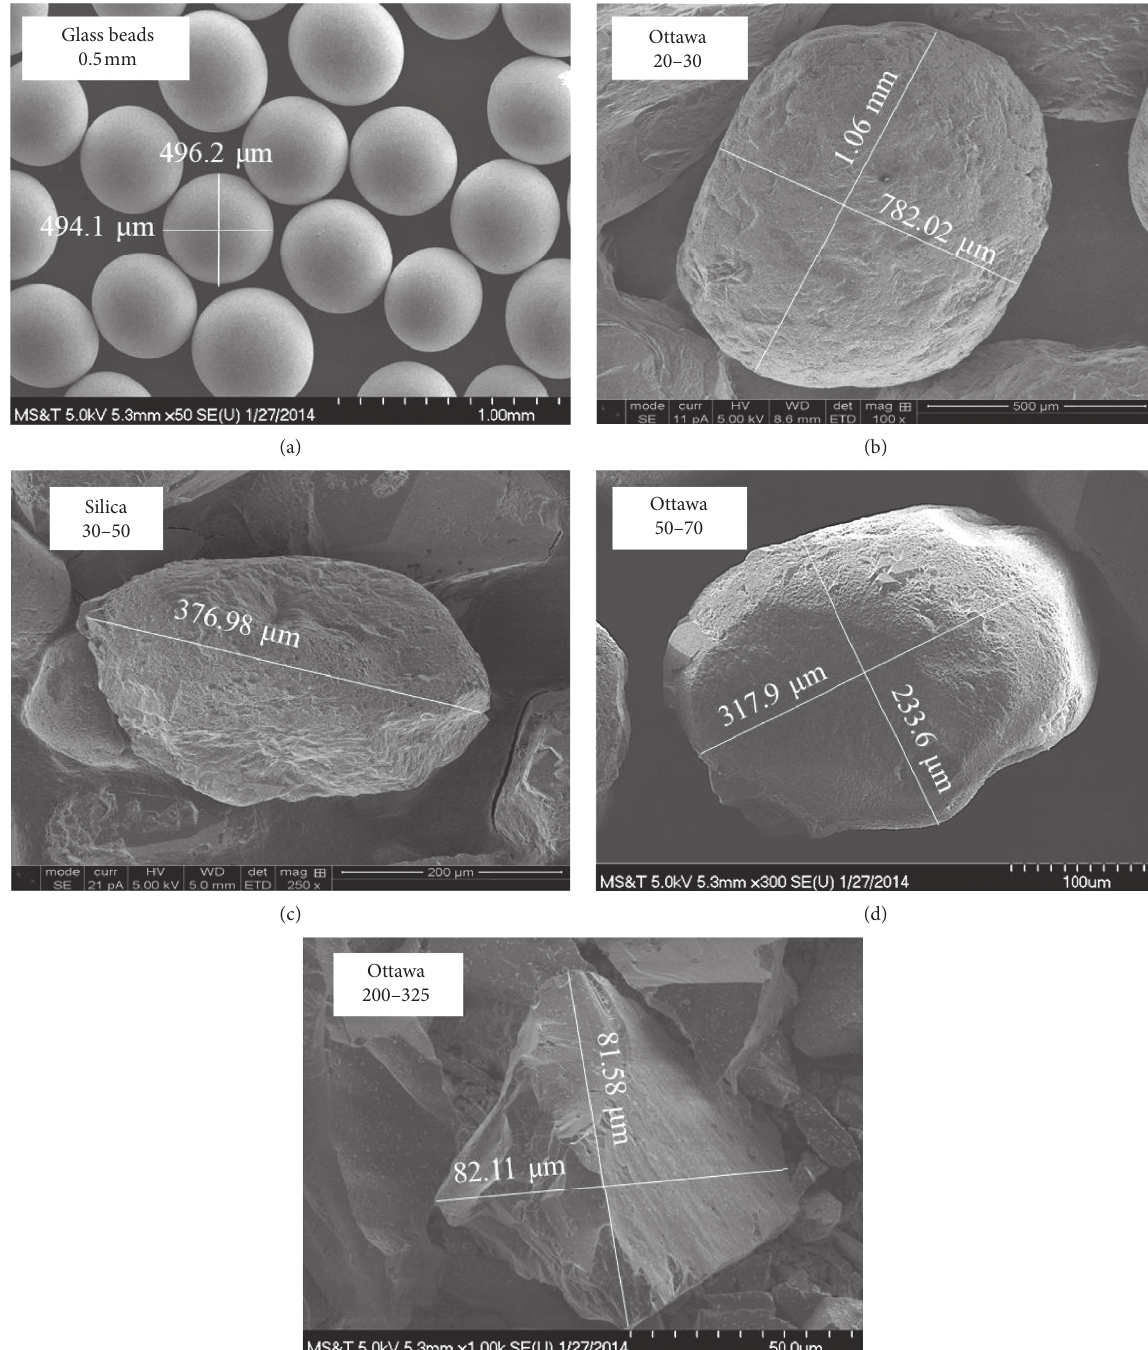
Figure 11: Scanning electron microscopy images of the GB, Ottawa sand, and Silica